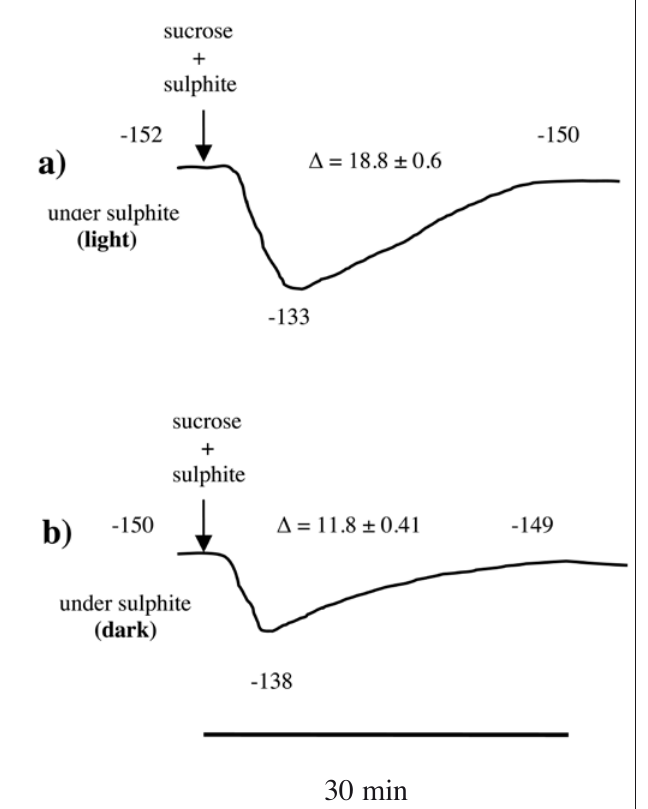
Fig. 4 - Short-term treatments in light and dark. Numbers preceded by - are negative mV. Electrophysiological traces are representative of five equivalent measurements. Δ is the depolarization (mV) as the mean of five measurements ± se.